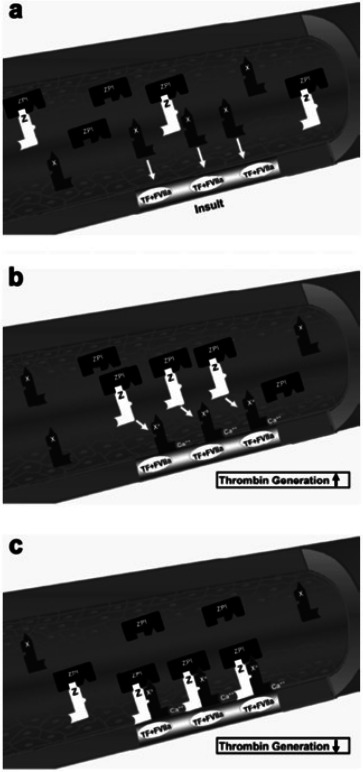
Factor X activation and protein Z/protein Z-dependent protease inhibitor (ZPI) inhibition of activated factor X.(A) The formation of the complex of tissue factor (TF) and factor VIIa (FVIIa) at the site of injury and activation of extrinsic coagulation cascade. (B) Activation of circulating factor X by the TF/VIIa complex in the presence of exposed phospholipids and Ca2+. (C) Inhibition of factor Xa (FXa) by the protein Z/ZPI complex by binding to its active site. Modified from Broze (2001).